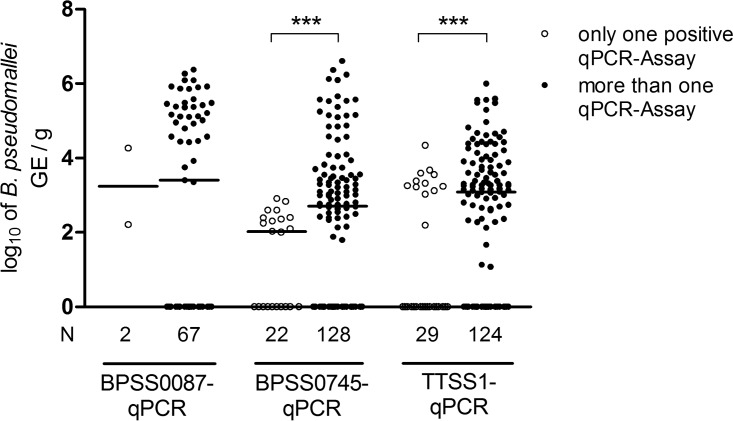
Comparison of B. pseudomallei GE in soil samples with only one and more than one positive qPCR assay(s). Scatter plot (with medians) comparison of log10-transformed GE as B. pseudomallei count per gram soil. B. pseudomallei GE of qPCR-positive samples were grouped (for each assay) in samples with one or more positive qPCR assays. Samples with a value of zero are the result of positive and negative subsamples in single qPCRs (see Materials and Methods), leading to a median of zero. N denotes the number of samples per group. ***, P < 0.001 as determined by a Mann-Whitney U test.